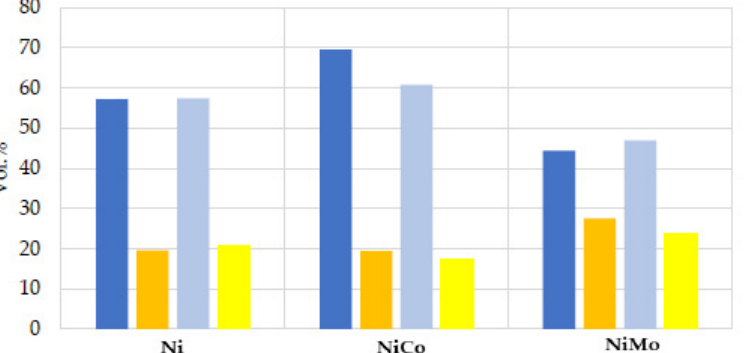
Figure 3. Methane and CO 2 content in the resulting hythane gas for Ni, NiCo and NiMo catalysts. Dark blue—CH 4 in the case of birch shavings; light blue—CH 4 in the case of ground apricot stones; dark yellow—CO 2 in the case of birch shavings; light yellow—CO 2 in the case of ground apricot stones.